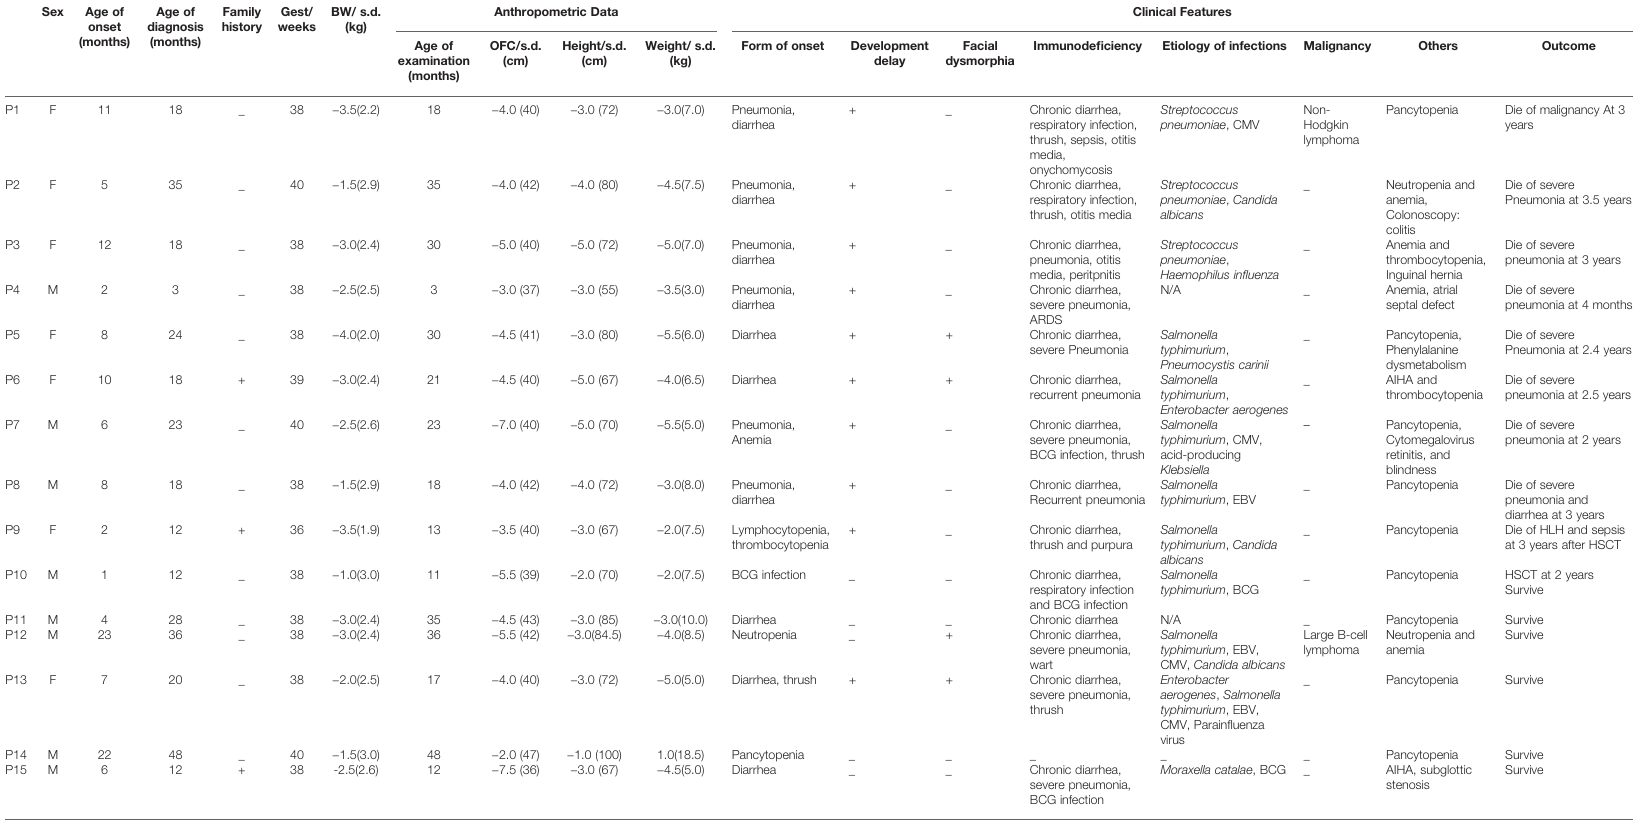
TABLE 1A | Anthropometric data and clinical characteristics. Sex Age of